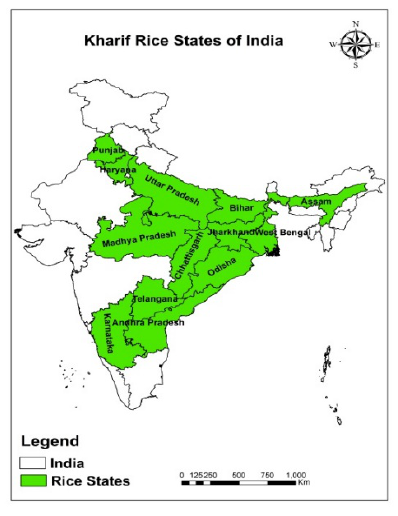
Figure 1: Study Area